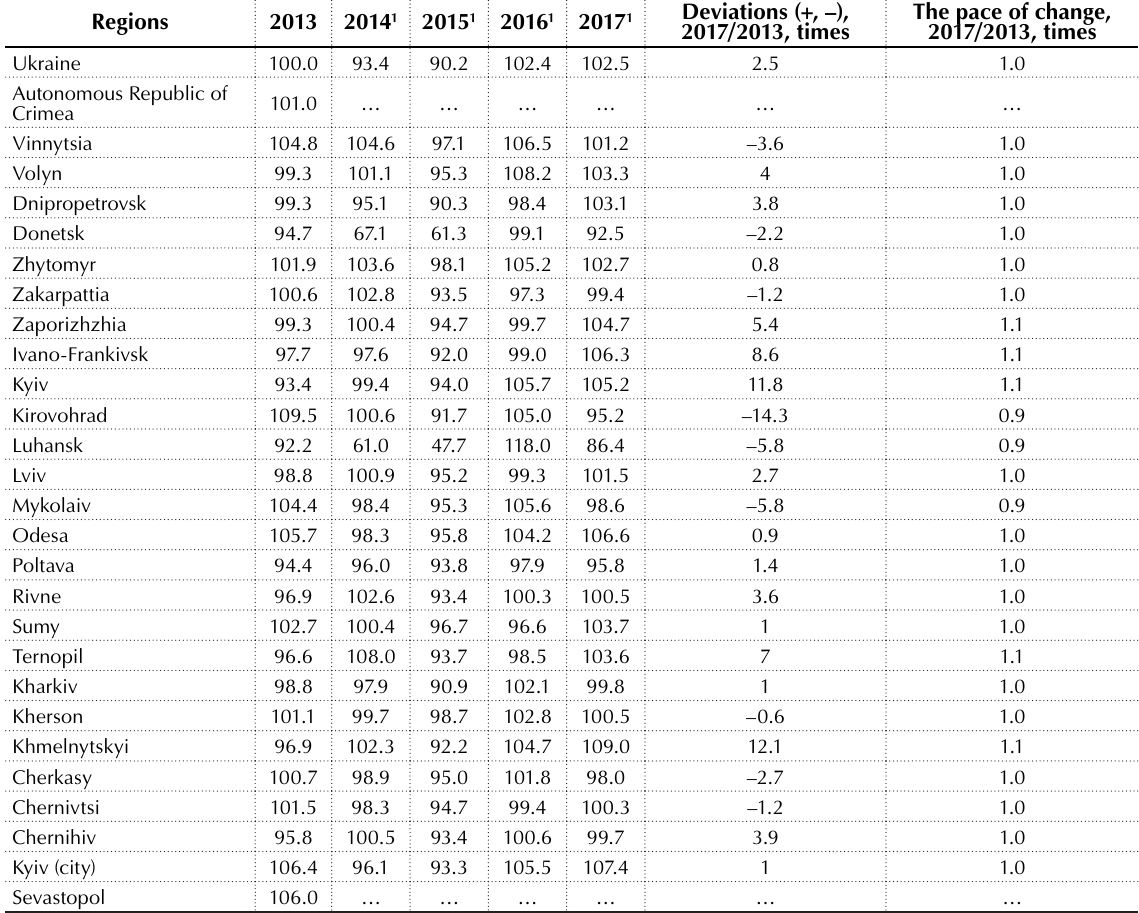
Table 3. Dynamics of the index of physical volume of gross regional product in comparative prices (in prices of the previous year) for 2013–2017 Source: Державна служба статистики України [Derzhavna sluzhba statystyky Ukrainy] (n.d.), State Treasury of